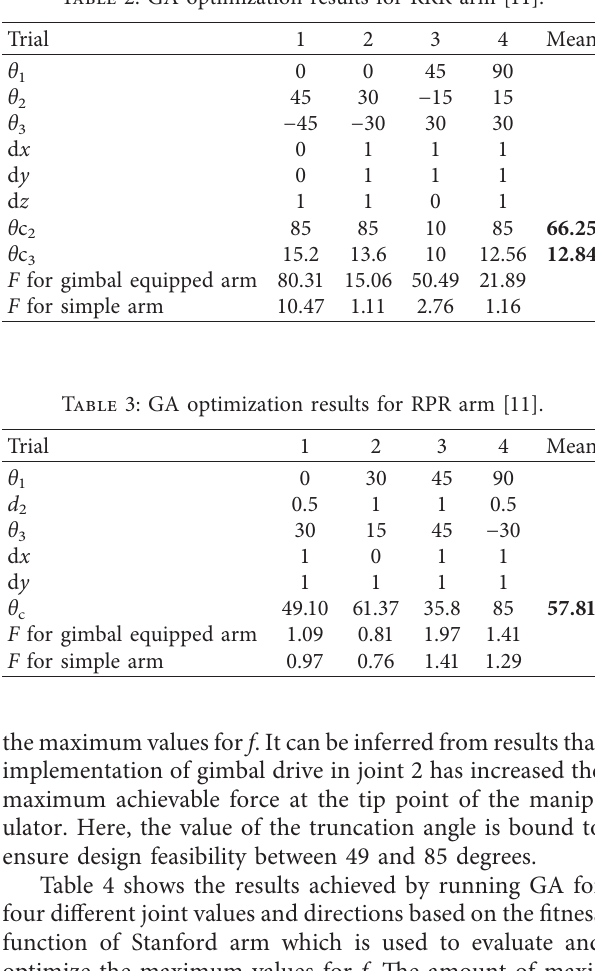
Figure 7: Normalized fitness function values in each step of GA optimization. Table 2: GA optimization results for RRR arm [11].